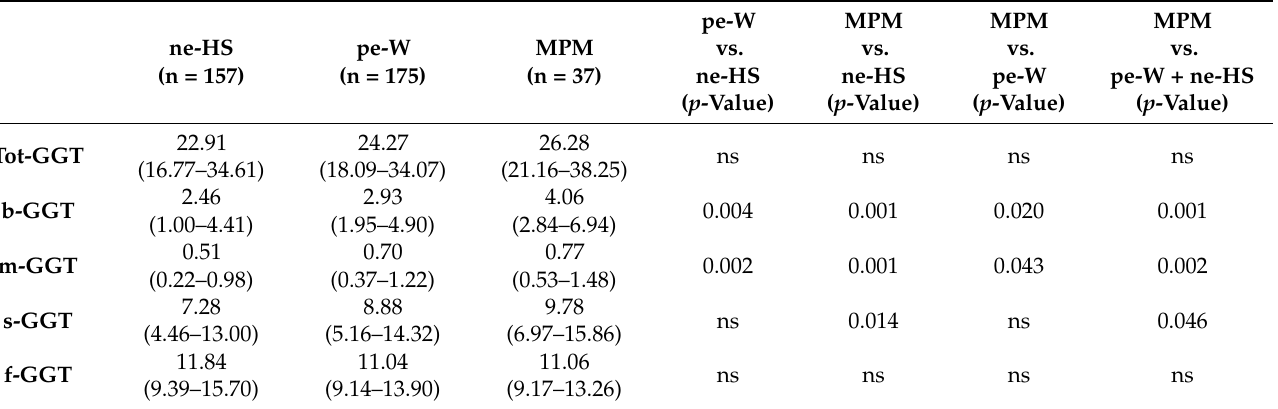
Table 3. Summary of the analysis of GGT fractions distribution when including the whole MPM group (MPM), the non-exposed subjects (ne-HS) and the previously exposed workers (pe-W); data are expressed as medians (25th–75th percentile) of enzymatic activity (U/L).